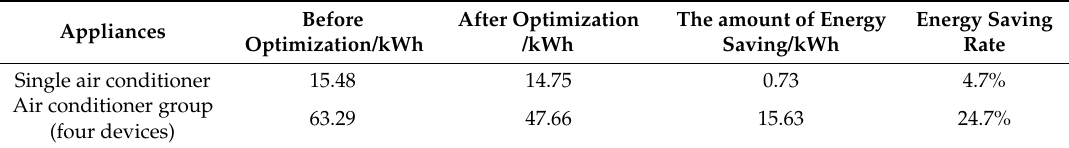
Table 2. The results of the energy saving simulation for an